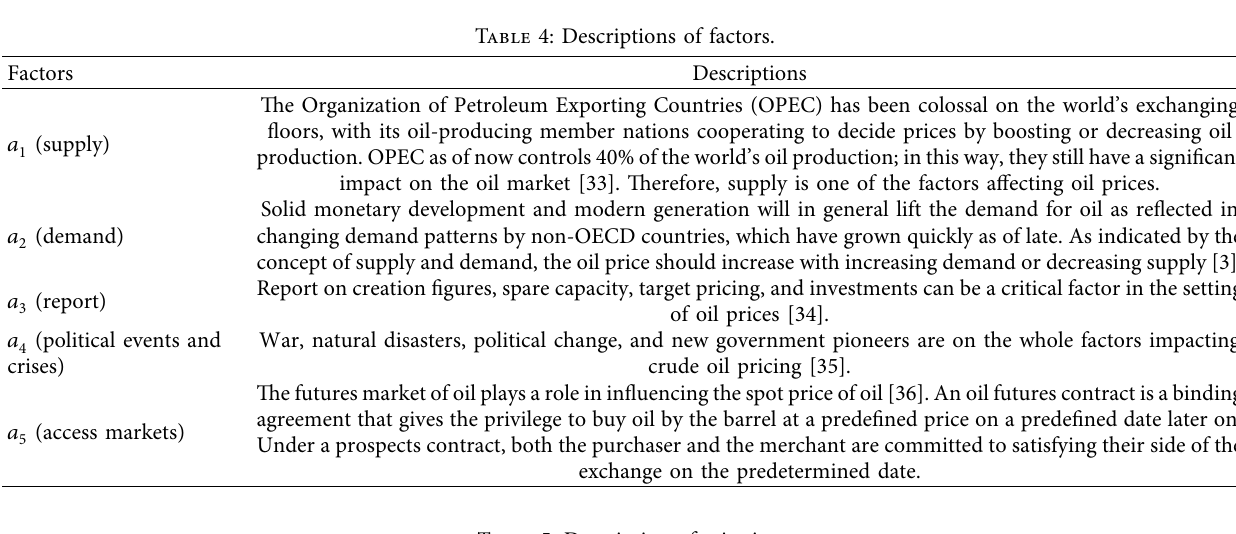
Table 5: Description of